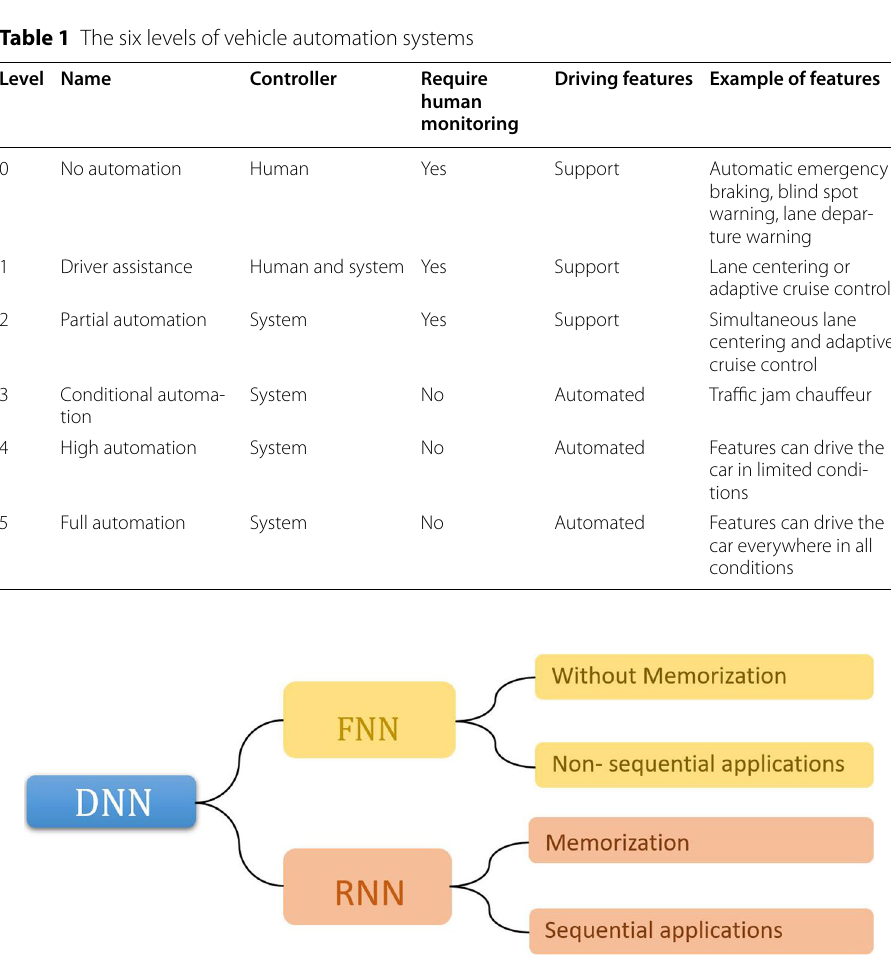
Fig. 2 The difference between RNNs and